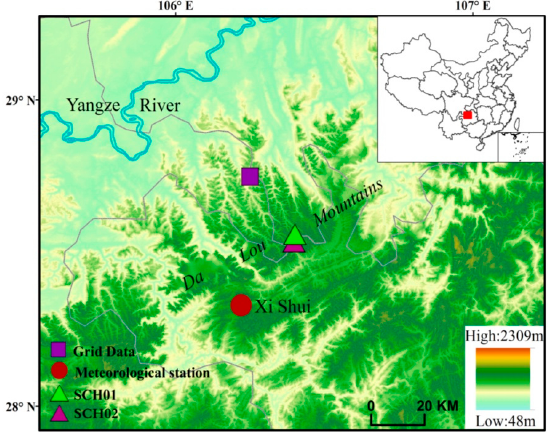
Figure 1. Location of the study sites in the northern part of southwest China. The sampling sites, grid data (28.75° N, 106.25° E), and nearest meteorological station (Xi Shui) are also shown. The overall location of the research region is shown in the inset map.